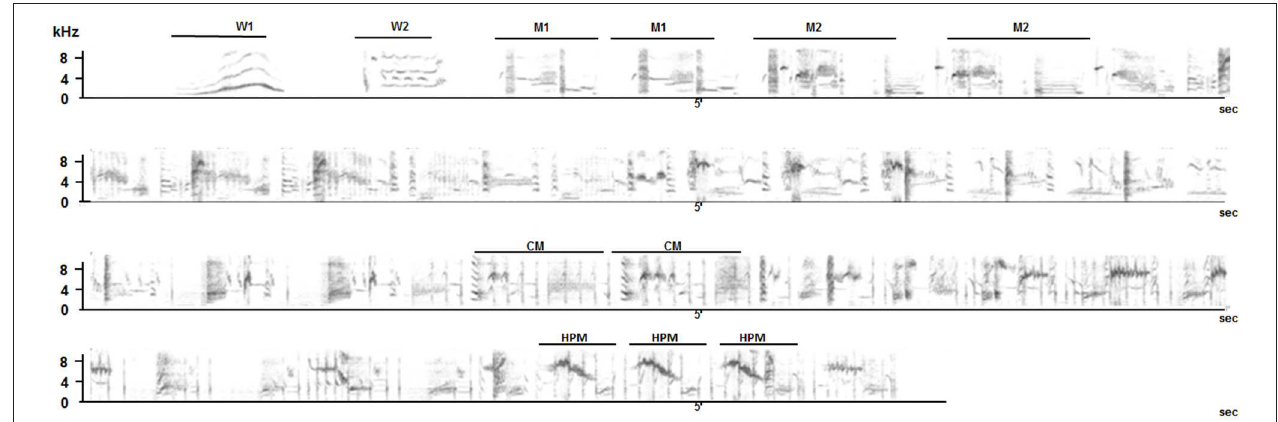
FIGURE 1 | Song sequence of a wild starling. The typical song sequence starts with two different types of whistles (W1 and W2). The warbling sequence starts with variable motif types (M1, M2 etc…) that can be repeated several times. Click motifs (CM) appear in the middle of the sequence. High pitched trill motifs (HPT) are characteristic of the end of the